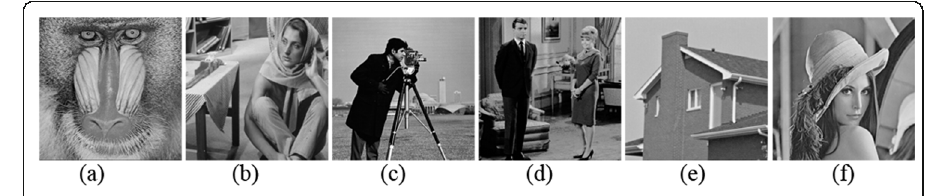
Fig. 4 Six original images used in the